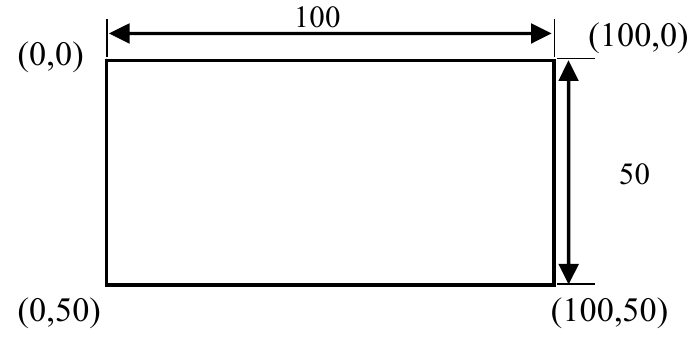
Figure 9. Bounding box output.